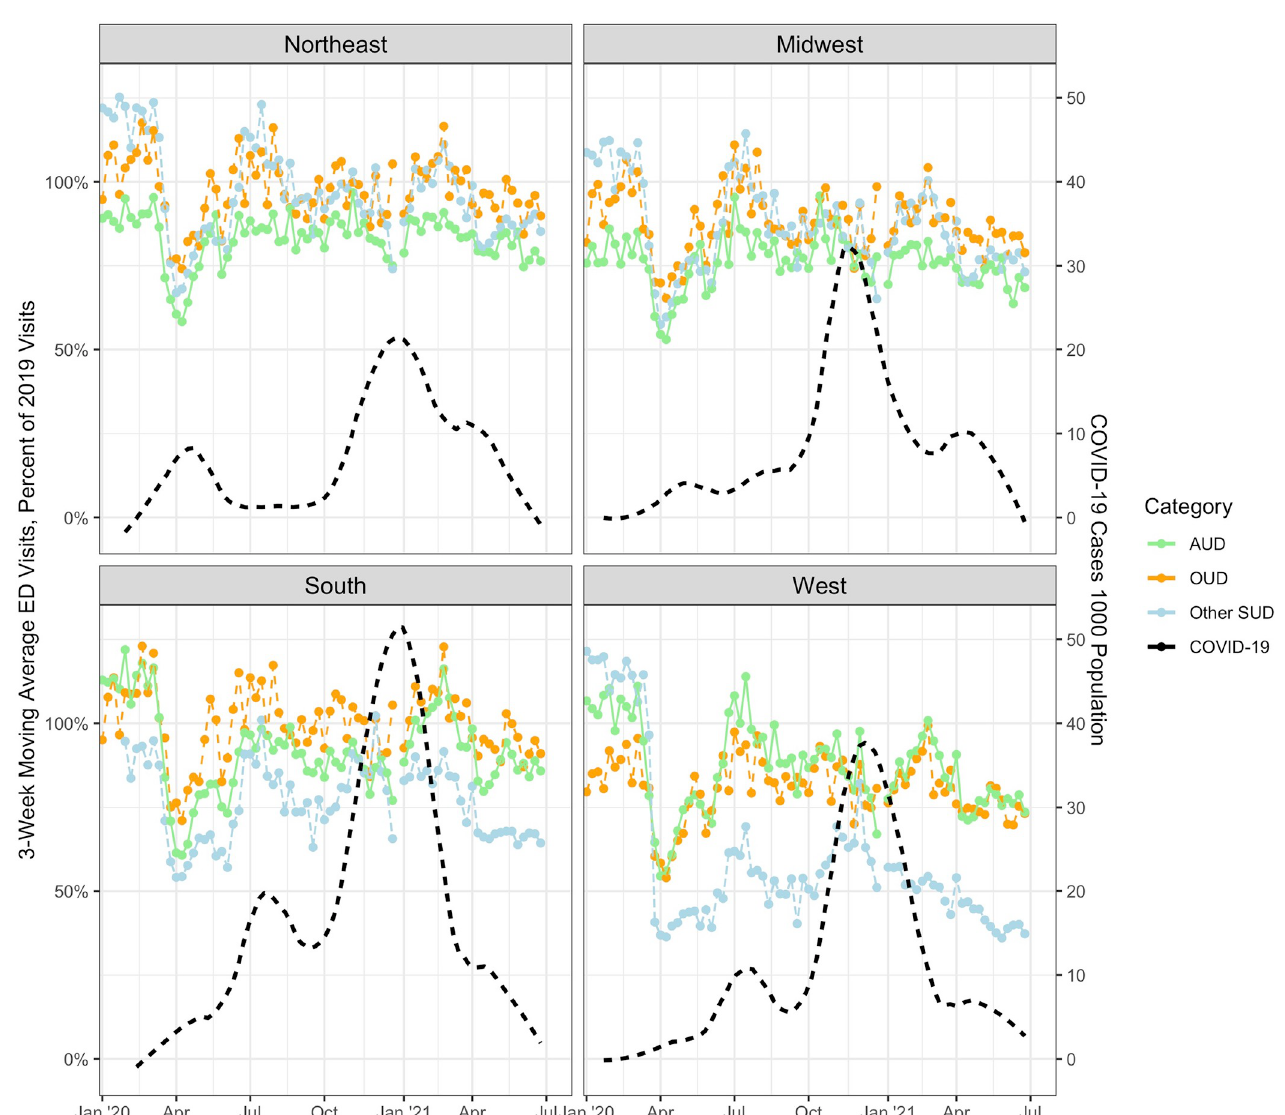
Fig 3. Trends in weekly ED visits for OUD, AUD, and other SUD-related, 2020, By US census regions. Note: Figure depicts 3-week moving average ratio of emergency department visit counts in 2020 and 2021 compared to identical weeks in 2019 in each U.S. Census Region. Sample includes 174 hospital-based Eds across 33 states from a national emergency department clinical quality registry. Visits for opioid use disorder (OUD), alcohol use disorder (AUD) and other substance use disorder (SUD)-related were identified by International Classification of Disease-10 codes.